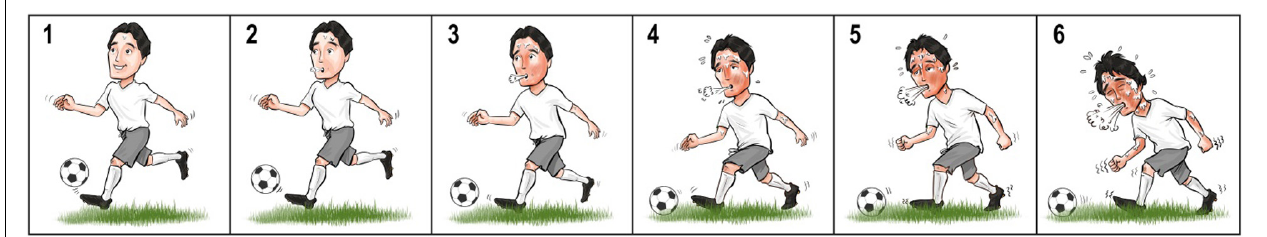
FIGURE 2 | GOAL Scale. Patent registration: BR 20 2018 072989 1.